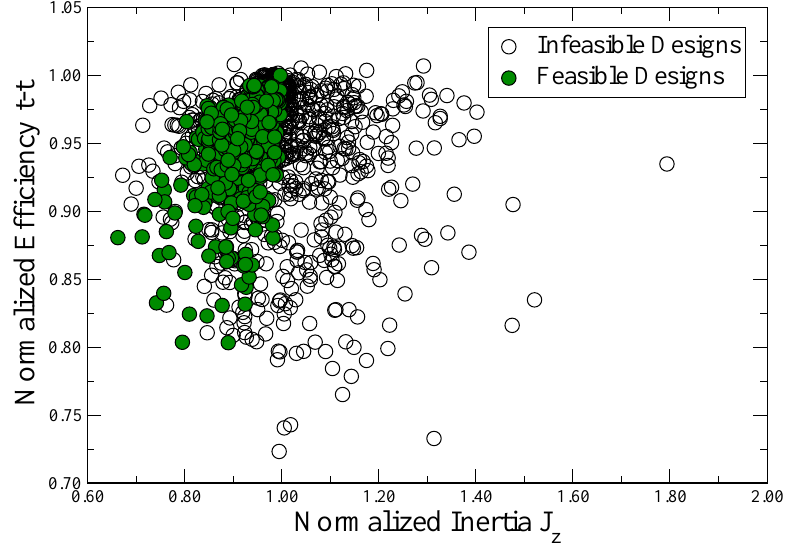
Figure 9. Optimization